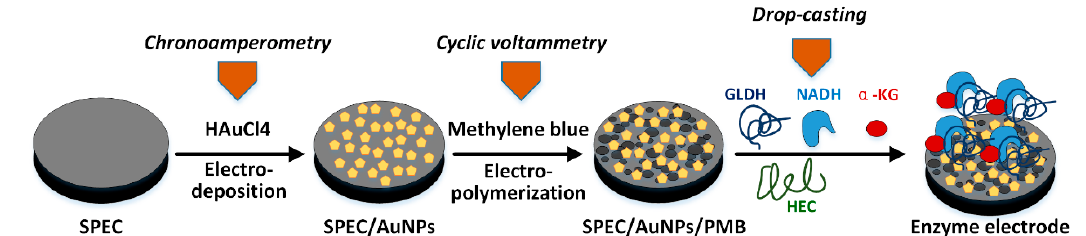
Figure 3. Multi step assembly process of enzyme electrode.